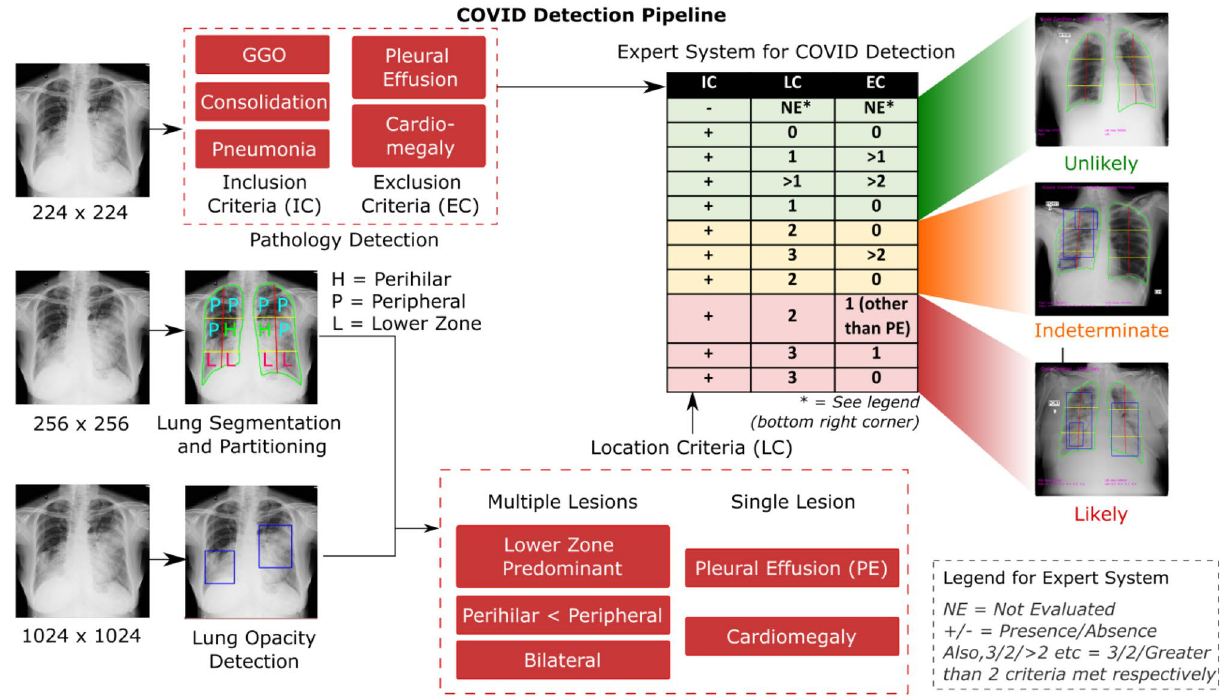
Figure 1. CovBaseAI model architecture for COVID likelihood